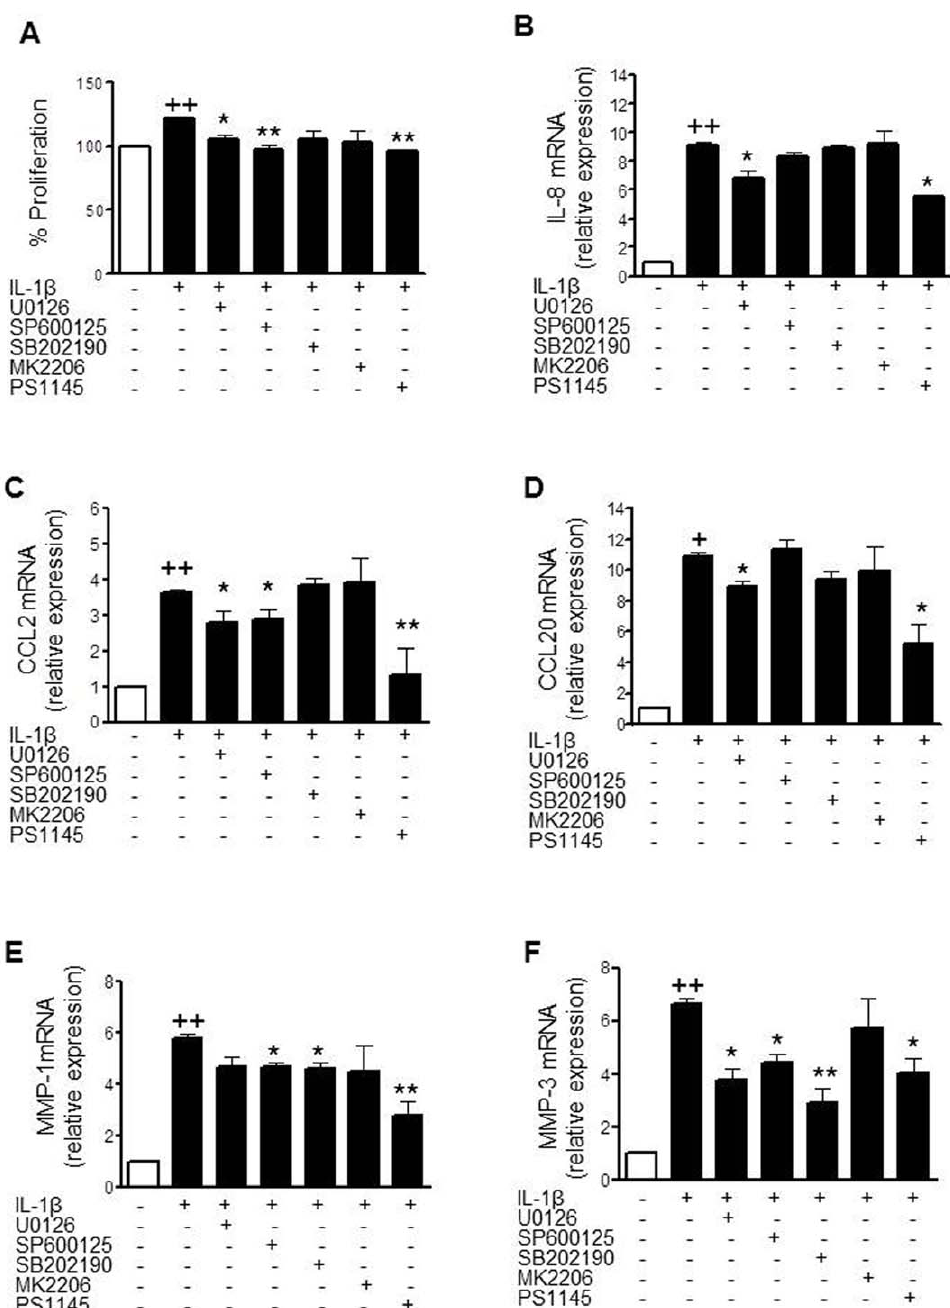
Figure 8. Effects of specific inhibitors of MAPK, Akt and NF- k B on IL-1 b induced cell proliferation and chemokine and MMP mRNA expression in OA synoviocytes. (A) Cell proliferation, (B) IL-8, (C) CCL2, (D) CCL20, (E) MMP-1, (F) MMP-3 mRNA expression. Cells were treated with UO126 (10 m M), SP600125 (25 m M), SB202190 (10 m M), MK2206 (20 m M) or PS1145 (10 m M), specific inhibitors of MEK/ERK1/2, JNK1/2, p38, Akt and I k B kinase, respectively, 1 h before adding IL-1 b for a total incubation time of 24 h (A) or 16 h (B–F). Cell proliferation was determined by the MTT method whereas mRNA expression was analyzed by real-time PCR. Data are expressed as mean 6 S.E.M. Duplicate samples from 3 patients were used. + P , 0.05, ++ P , 0.01 with respect to nonstimulated cells. * P , 0.05, ** P , 0.01 with respect to IL-1 b .